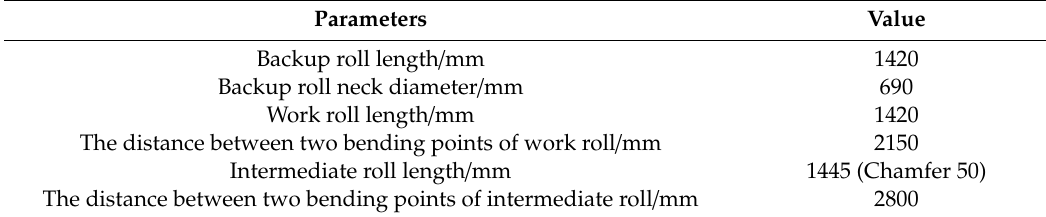
Table 1. 1420mmUCM reversible mill geometry parameters.